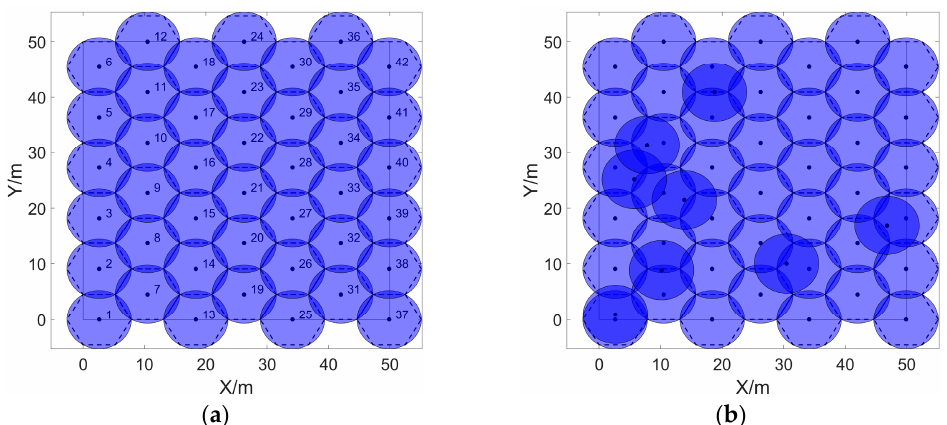
Figure 5. Coverage effects of sensors. ( a ) shows that the sensing area is completely covered when it satisfies the condition N S = N ub ; ( b ) shows that the sensing area is completely covered and 8 sensors are redundant when using 50 sensors to cover 42 cellular grids.